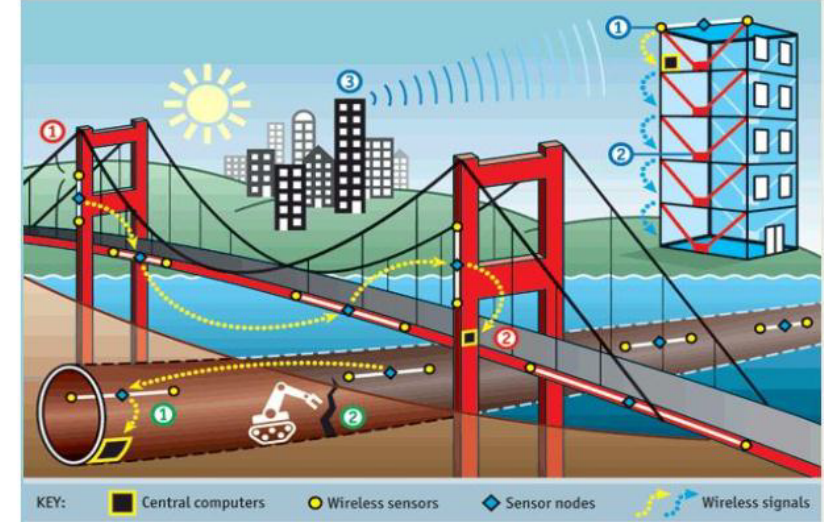
Figure 2. Structural health monitoring using wireless sensor networks